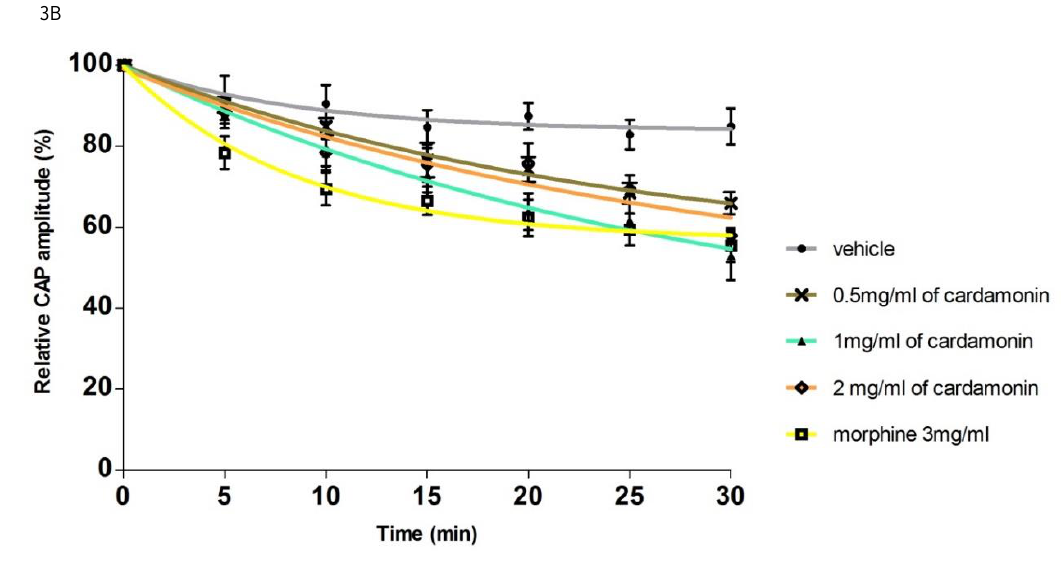
Figure 3B: Comparison in average time course among CAP peak amplitude changes produced by vehicle, cardamonin (05, 1 and 2 mg/mL) and morphine (3mg/mL).